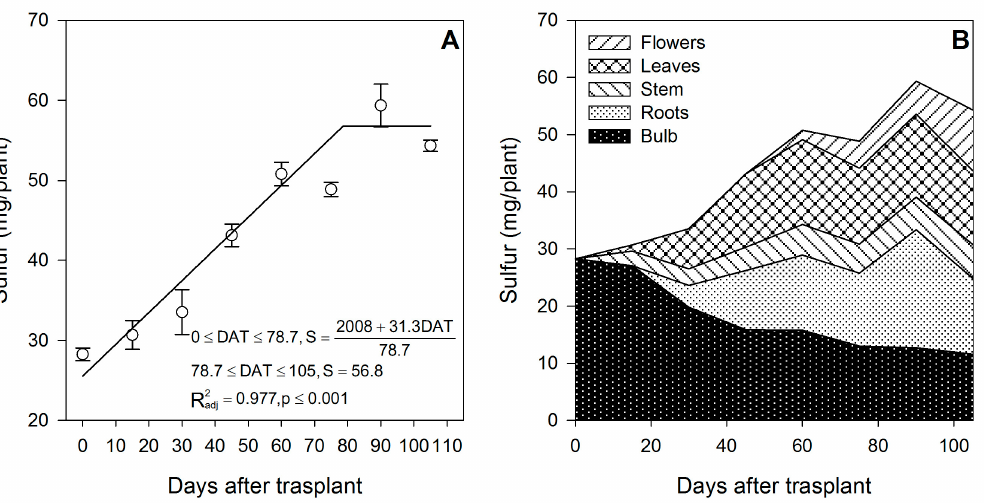
Figure 7. Sulfur accumulation in lilium: ( A ) Segmented analysis of sulfur accumulation over the growing season; ( B ) Sulfur distribution in the lilium plant parts. Day 0 = transplant day, days 0 to 15 = sprouting and initial vegetative growth, days 15 to 60 = rapid vegetative growth plus flower buds formation, days 60 to 105 = blooming. DAT = days after transplant.